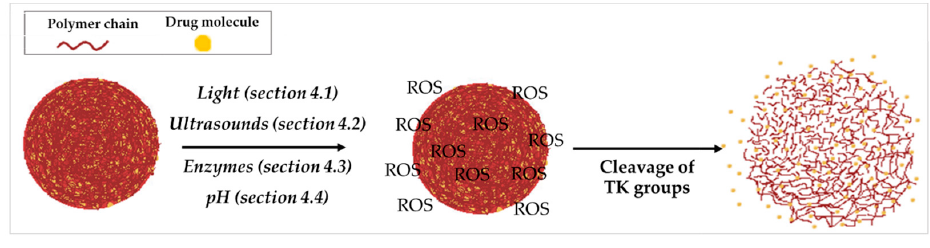
Figure 5. Schematic illustration of the release mechanism of a TK-based DDS in association with other stimuli.